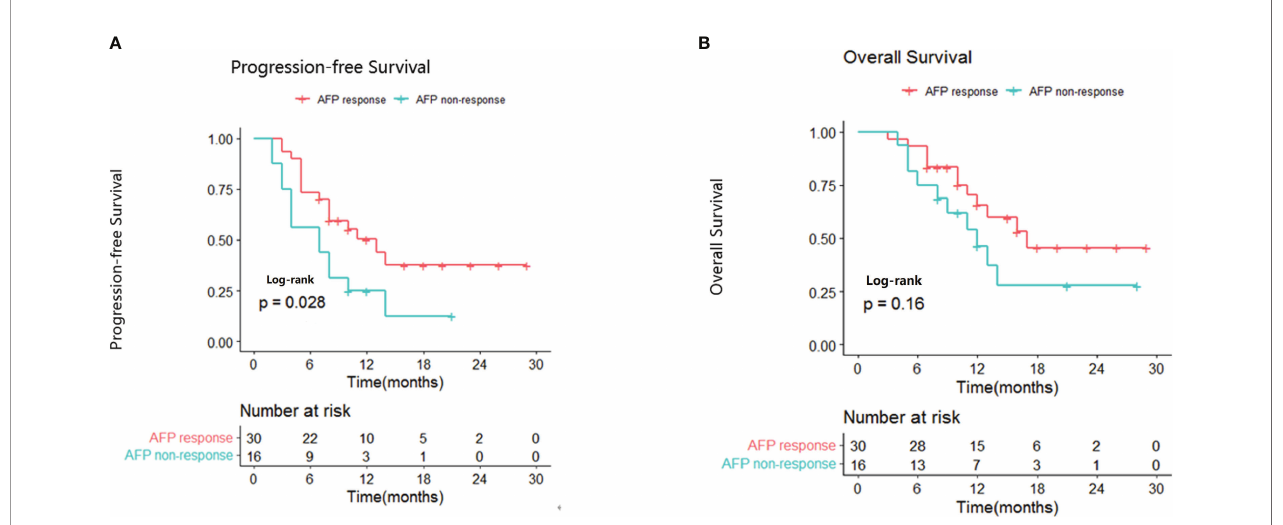
FIGURE 1 | Kaplan-Meier curves for progression-free survival (A) and overall survival (B) in AFP responders and non-responders.